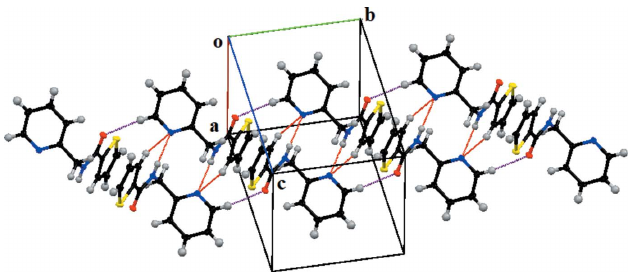
Figure 3 (10) formed by a pair of N— 2 Packing diagram showing the formation of [010] chains linked by N—